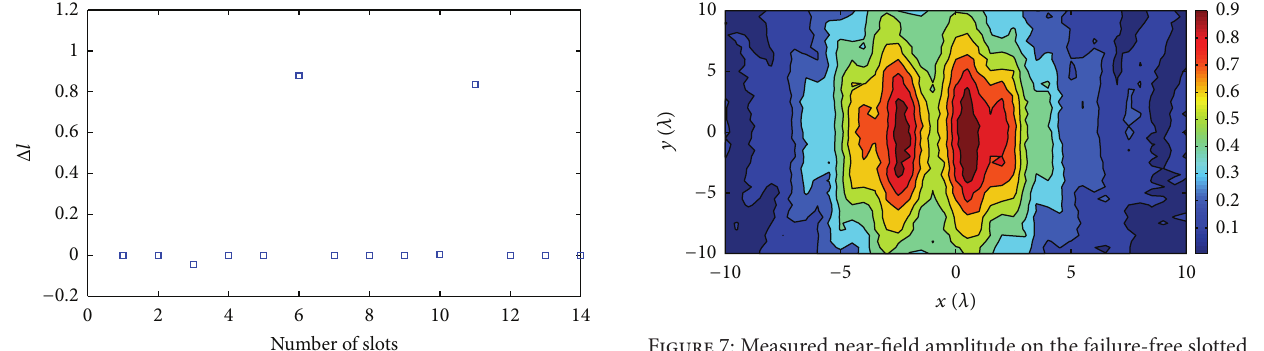
Figure 7: Measured near-field amplitude on the failure-free slotted waveguide array.